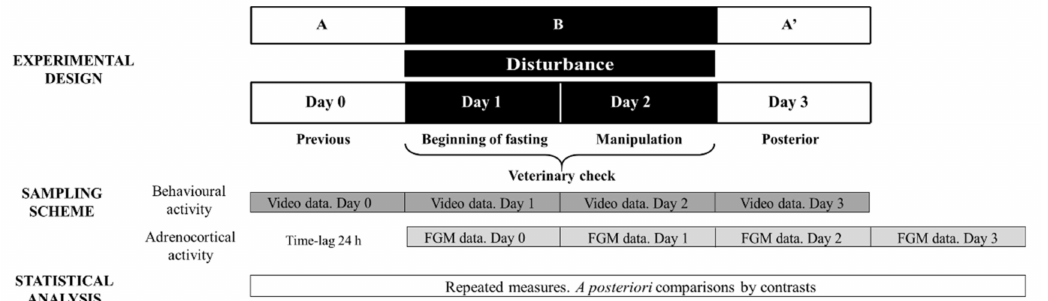
Figure 1. Representative diagram of the experimental and methodological approach used during Study 2 to evaluate veterinary check effect on behavioural and adrenocortical activity. FGM = faecal glucocorticoid metabolites. The ABA experimental design applied: day 0 (previous-stage A), days 1 and 2 (disturbance—stage B) and day 3 (posterior-stage A (cid:48)